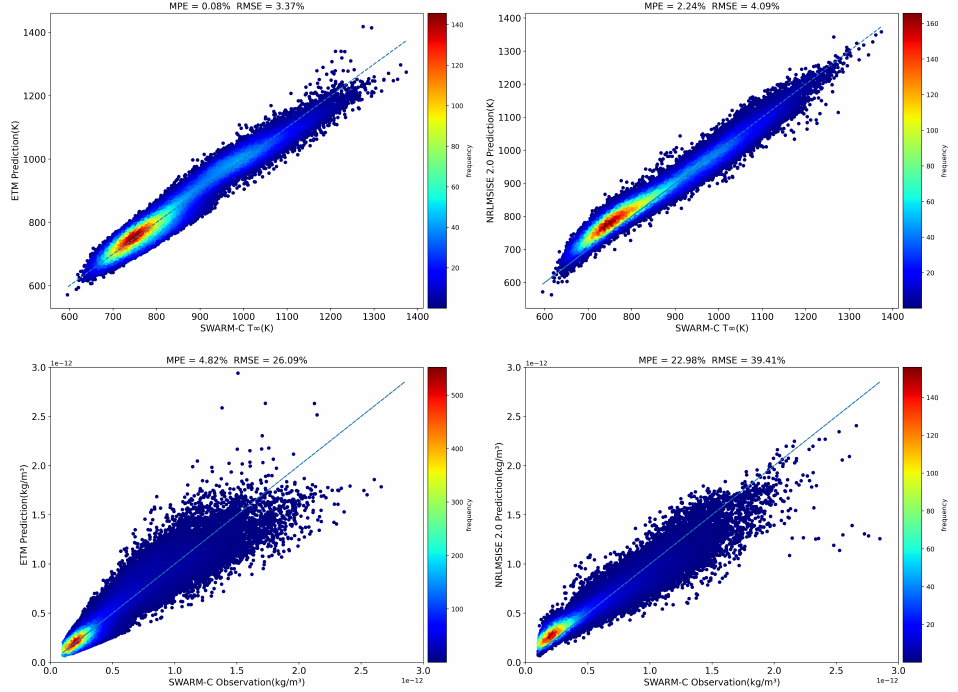
Figure 5. Scatter plots of thermospheric density from SWARM-C ( top ) and GRACE-FO data ( bottom ). Left : ETM; Right : NRLMSIS 2.0 model.